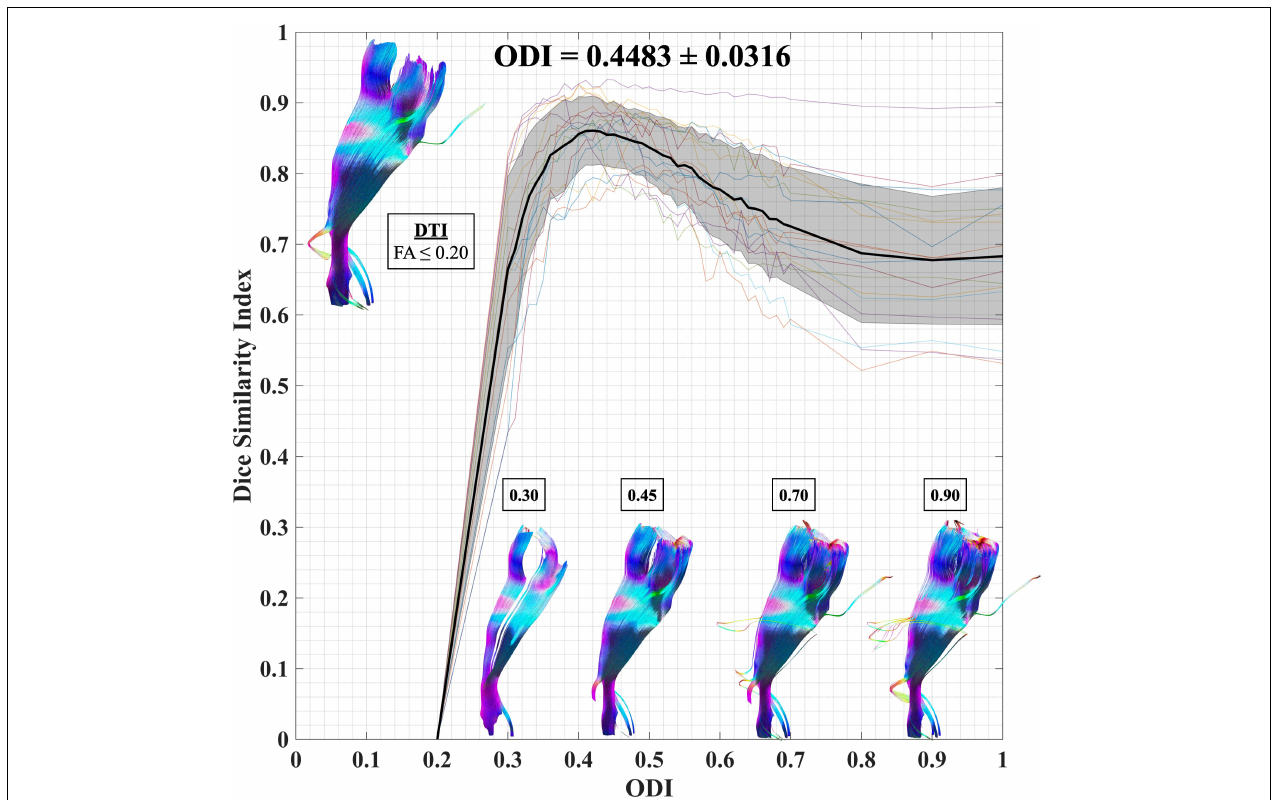
FIGURE 5 | ODI threshold calibration for CST. We have studied the dice similarity index at each considered ODI threshold compared to the standard DTI termination criteria (FA ≤ 0.2; turning angle ≥ 60 ◦ ). An optimal ODI ≥ 0.45 has been set for CST reconstruction. ODI, orientation dispersion index; CST, corticospinal tract; and DTI, diffusion tensor